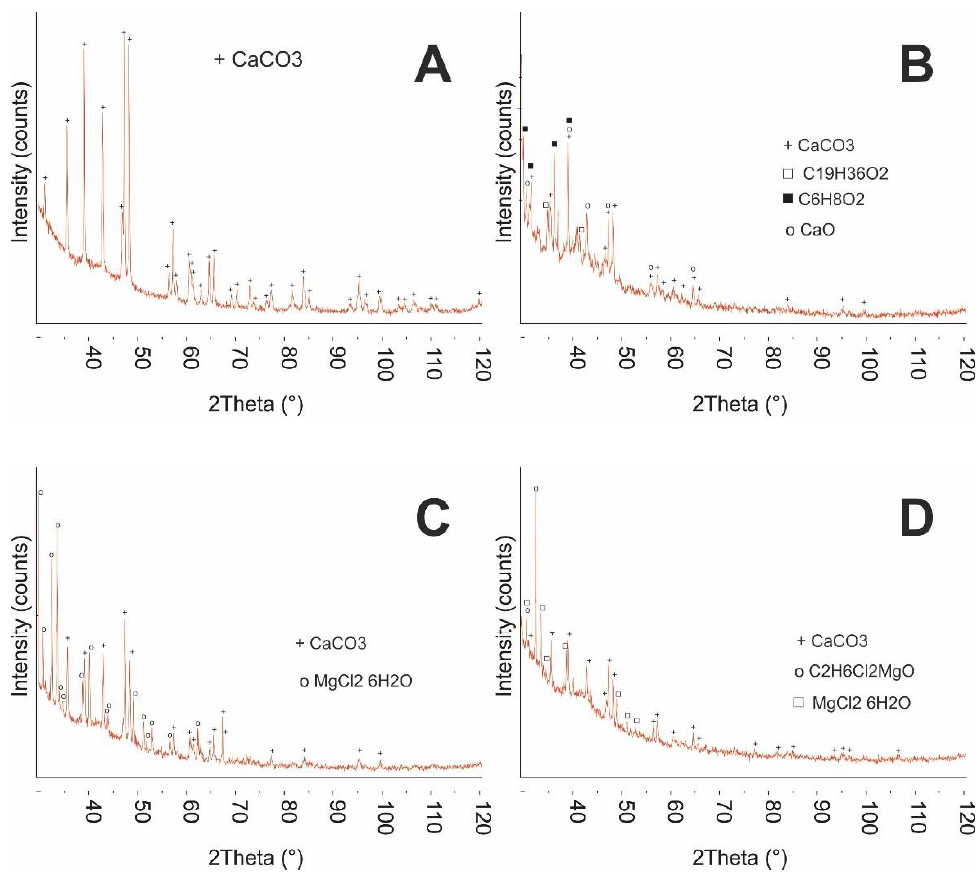
Figure 2. XRD diffractograms of studied calcium matrices. ( A ) EC, ( B ) ELI, ( C ) ECM, ( D ) EK.